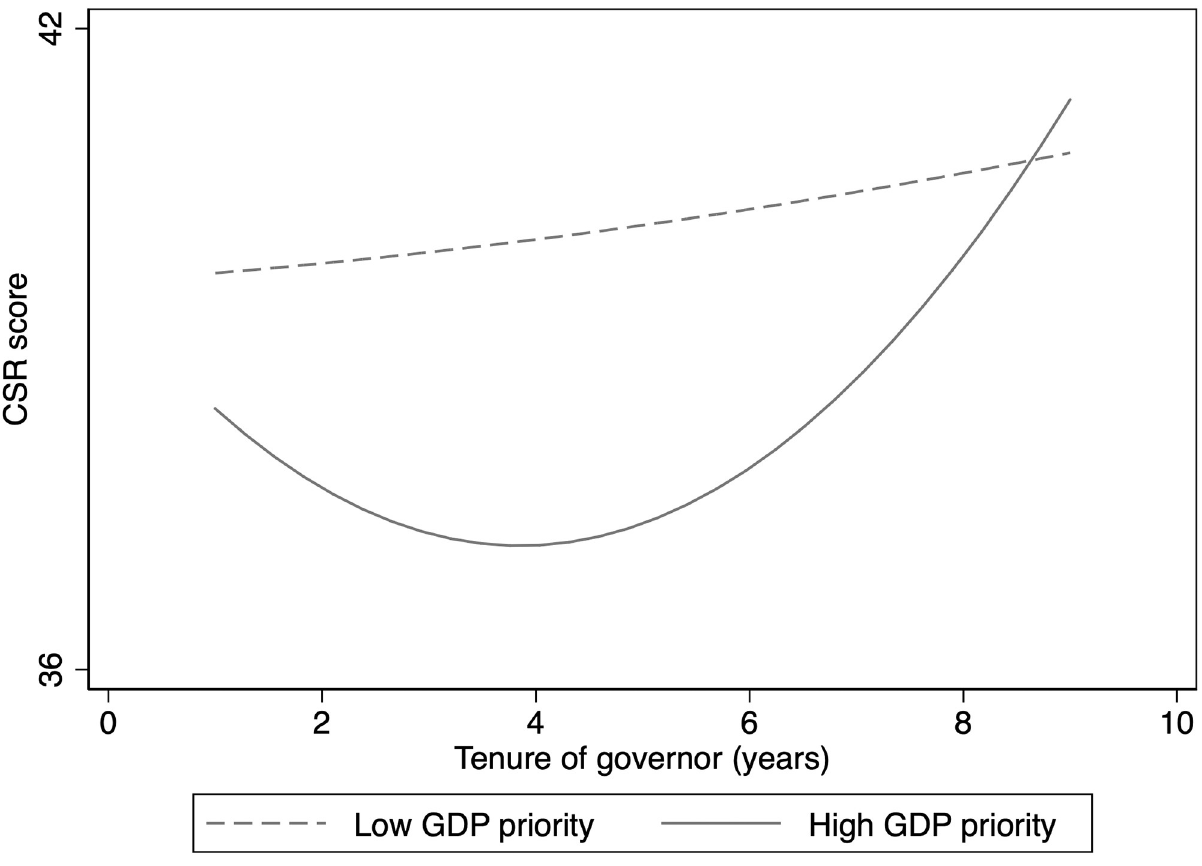
Fig 1. Moderating effect of regional GDP